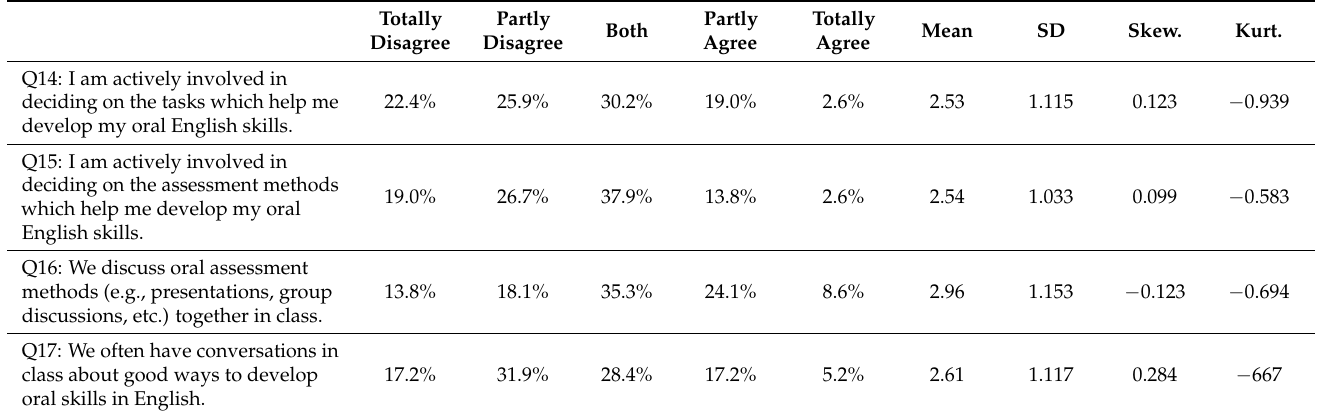
Table 3. Students’ views on participation and dialogue in